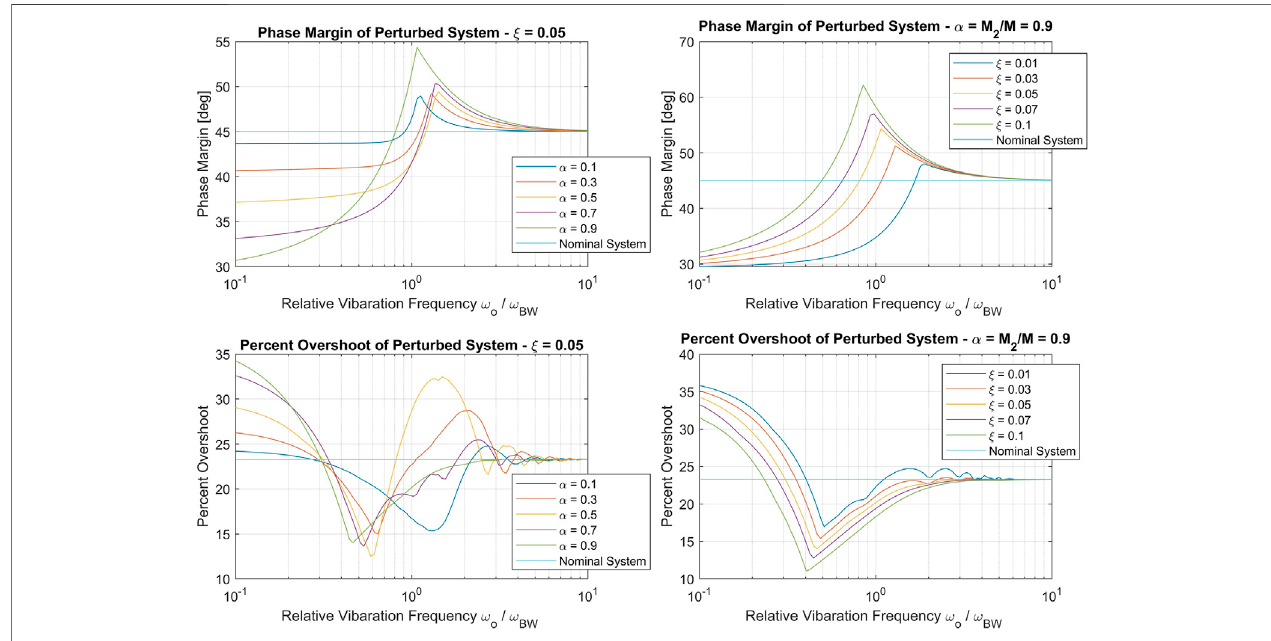
FIGURE 7 | phase margin (top row) and Percent overshoot (bottom row) of the perturbed control system with vibration frequency ω o normalized by designed bandwidth ω BW . The left column shows the effect of vibrating inertia fraction α , while the right column shows the effect of vibrational damping.